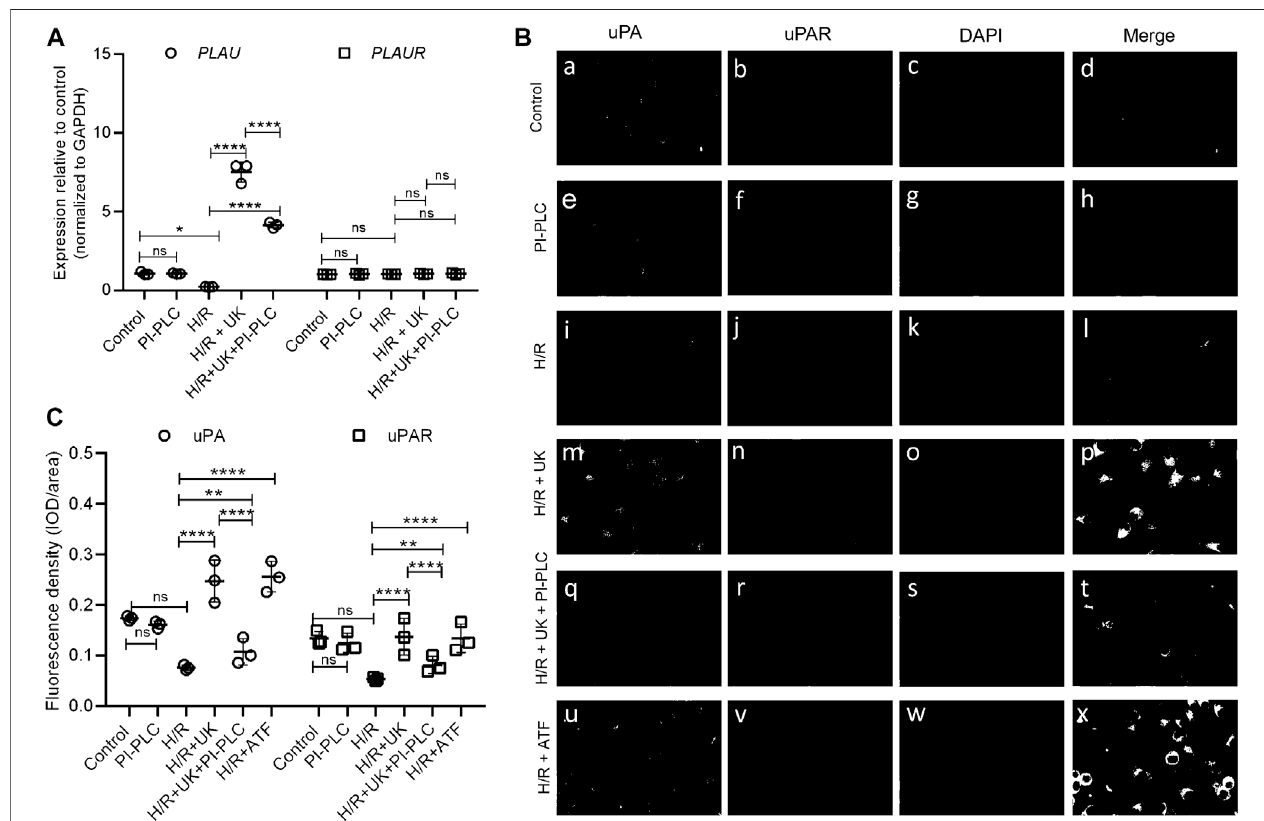
FIGURE 2 | Exogenous uPA treatment induces uPAR protein expression without changes in its transcript expression. (A) Relative expression of PLAU (encoding uPA) and PLAUR (encoding uPAR) was determined in indicated conditions using RT-qPCR. Data are represented as mean ± SD; ** p < 0.05, **** p < 0.0001, ns, not signi fi cant( n =3). (B) Representativeimmuno fl uorescenceimagesofuPAanduPARexpressioninBEAS-2Bcells,includingcontrolgroup(a – d)andcellssubjectedtoPI- PLC (e – h), H/R (i – l), H/R + UK (m – p), and H/R + UK but pretreated with PI-PLC (q – t). Scale bar, 100 μ m. (C) Relative expression of uPA and uPAR. The relative expression was based on the fl uorescence intensity of IF and the signal was quanti fi ed using Image-Pro Plus (UK: urokinase).